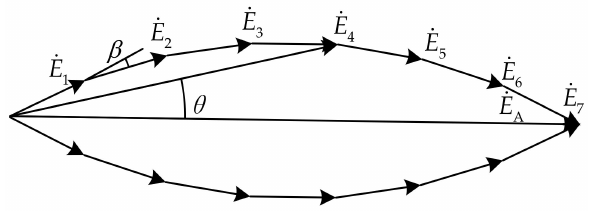
Figure 2. Distribution of generator turn